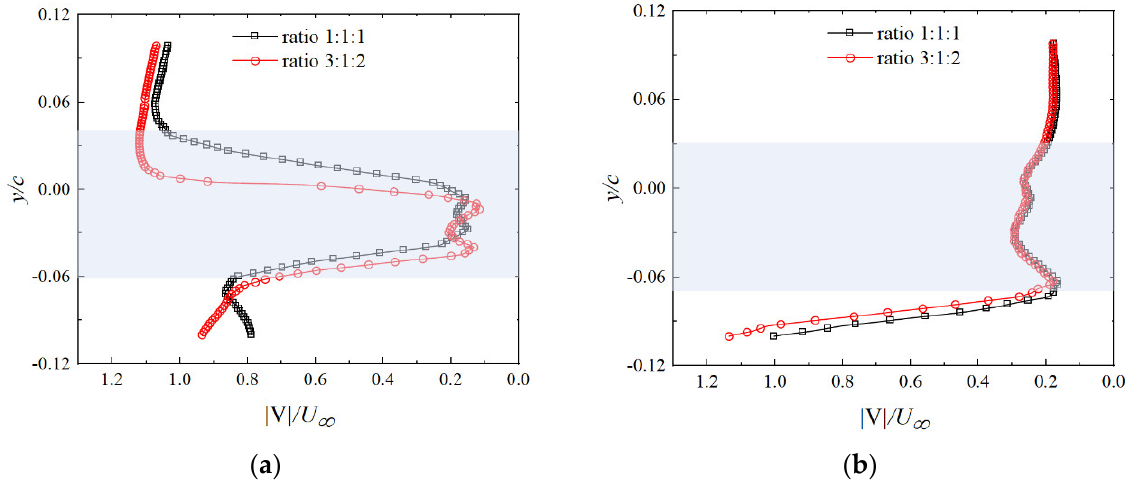
Figure 19. Near-field wake profiles with different blowing ratios ( U ∞ = 8 m/s, x/c = 1). ( a ) AoA = 0°. ( b ) AoA = 20°.